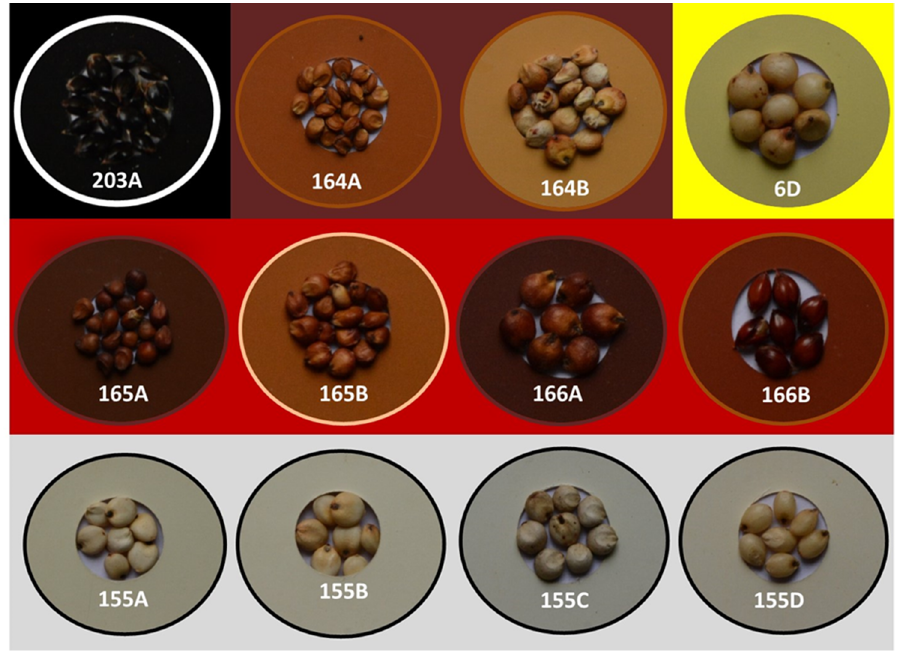
Figure 1. Assigning grain color to the diverse sorghum accessions using Royal Horticulture Society (RHS) color chart.